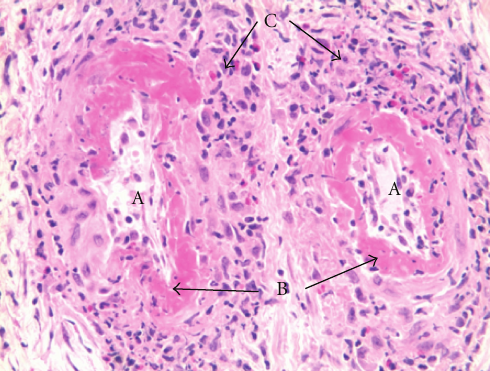
Figure 1: Abdominal computerized tomography performed after urinary diversion by ureteral stent. The figure shows a right iliac ureteral mass (white arrow) below the right iliac artery cross.